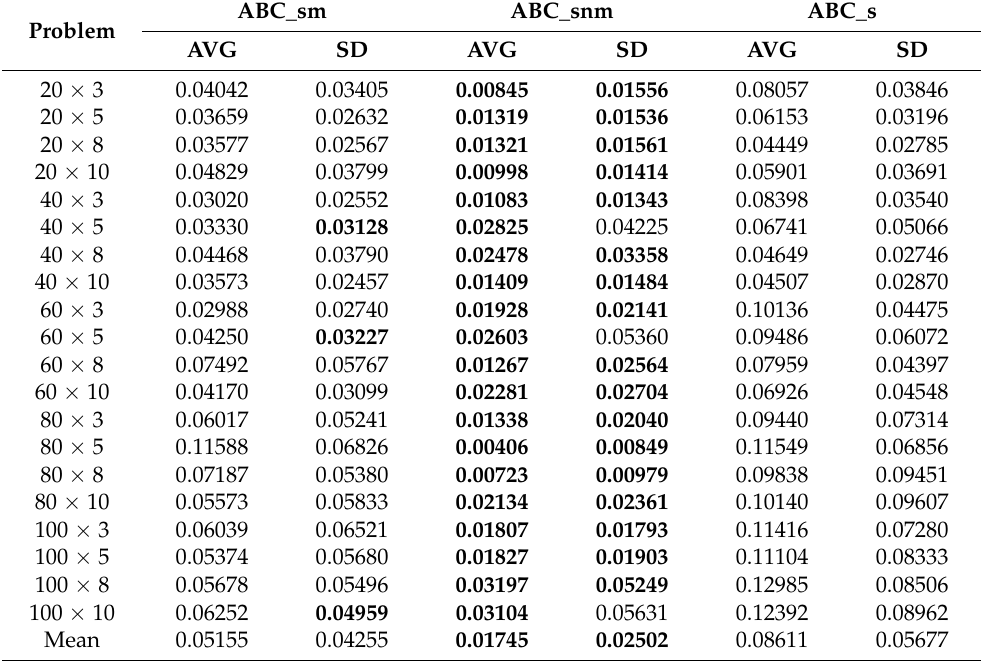
Table A6. IGD -metric for selection